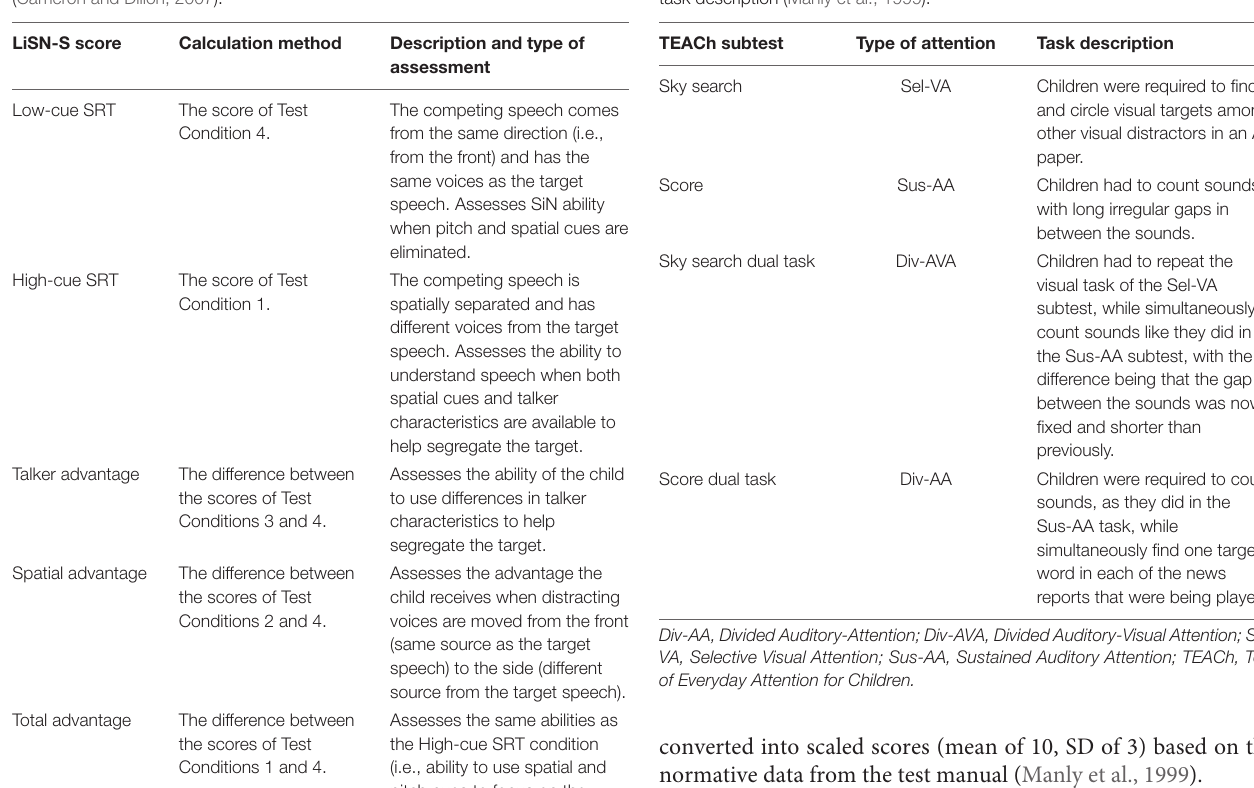
TABLE 3 | The four TEACh subtests, the type of attention they measure and their task description (Manly et al.,